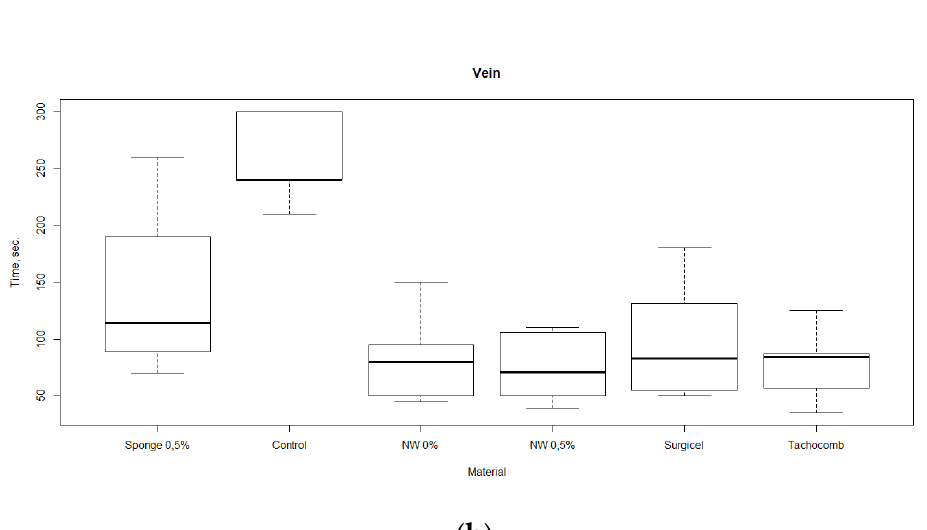
Figure 4. Rates of bleeding arrest (time until cessation of bleeding) in the experiments with different materials, in which femoral ( a ) and vein ( b ) artery hemorrhages were modeled.